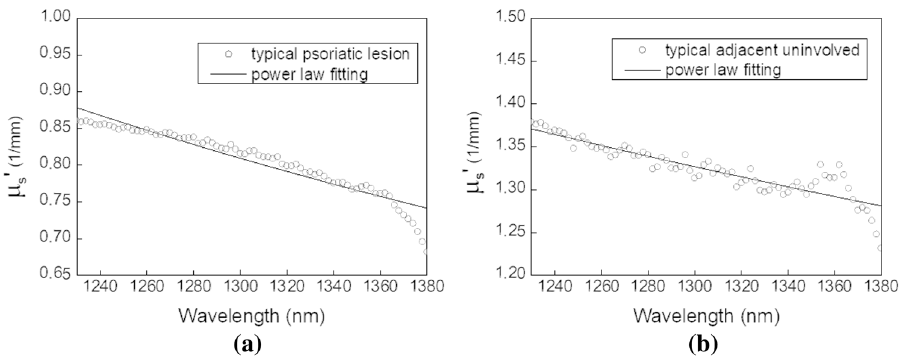
Figure 6. Typical skin reduced scattering spectra of psoriatic lesion site and its adjacent uninvolved site of the representative psoriasis subject at the “first overtone” of water absorption. The reduced scattering spectra of ( a ) the psoriatic lesion site and ( b ) its adjacent uninvolved site are shown in dotted lines. Best power law fitting to the skin reduced scattering spectra are shown in solid